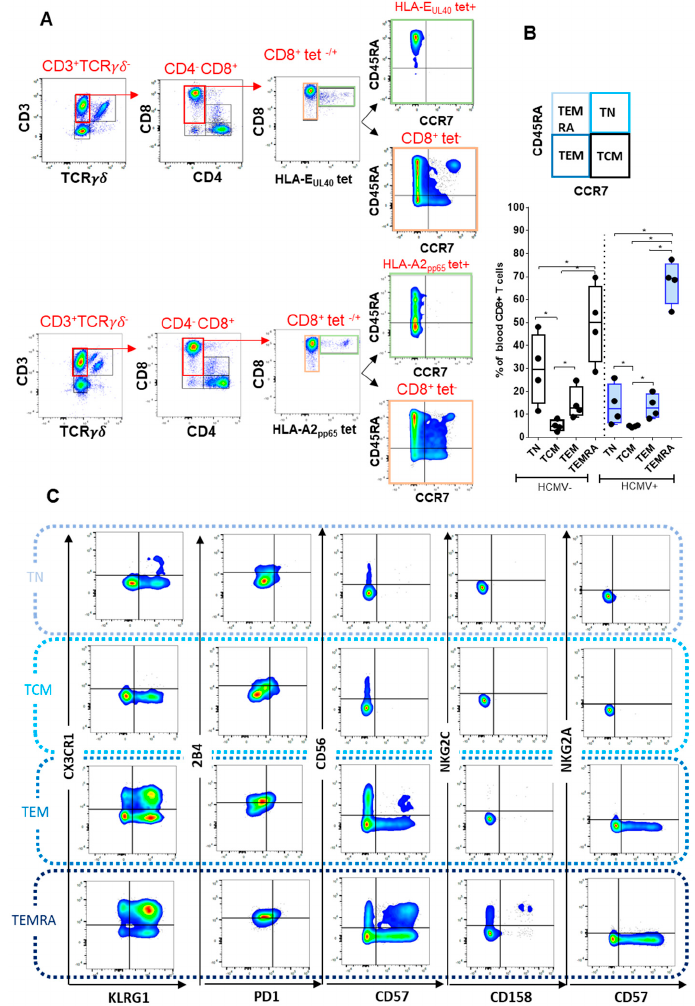
Figure 2. Analysis of CD8 T cell differentiation. ( A ) Representative density plots showing the sequential gating of CD8 T cells negatively (tet-) and positively (tet+) stained by pMHC class I tetramer (HLA-E UL40 VMAPTSLLL, upper panel or HLA-A2 pp65 , lower panel) after a selection according to CD4 and CD8 costaining among the CD3 + TCR γδ - lymphocytes. The expression pattern for CD45RA/CCR7 of each population (tet - and tet + ) is shown. ( B ) A schematic representation of CD8 differentiation stages including CD8 naive T cells (TN), central memory T cells (TCM), effector memory T cells (TEM), and terminally differentiated T cells (TEMRA) according to CD45RA and CCR7 expression is indicated (upper panel). A graphical and statistical analysis of differentiation for total CD8 T cell pool from independent HCMV - (n = 4) and HCMV + ( n = 4) individuals. Data are expressed as box plot with median and interquartile values. ( C ) Immunophenotyping of CD8 T cells for receptors for T cell activation and inhibition (2B4, PD-1, CD158, NKG2A, NKG2C, KLRG1), migration (CX3CR1) and cytotoxic capacity (CD56, CD57). The coexpression of receptors are shown for the 4 differentiation states (TN, TCM, TEM, TEMRA) analyzed for total CD8 T cells and representative of a single HCMV+ individual. p value: * for p < 0.05.